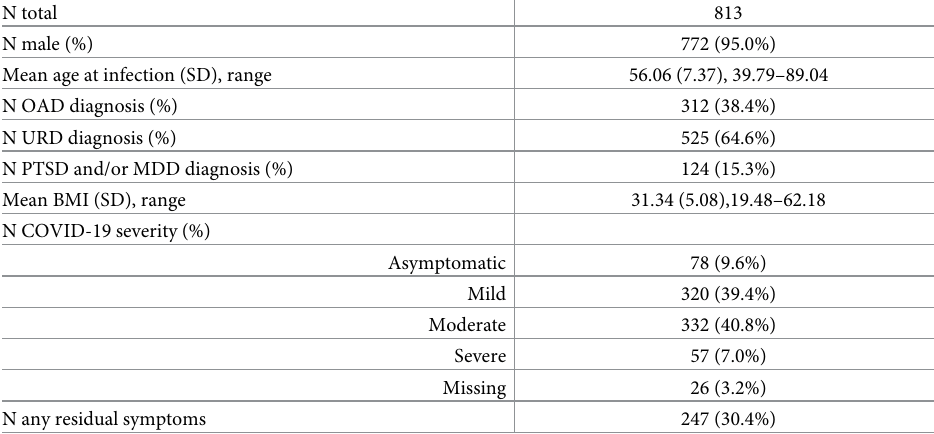
Table 1. Descriptive statistics for participants of European